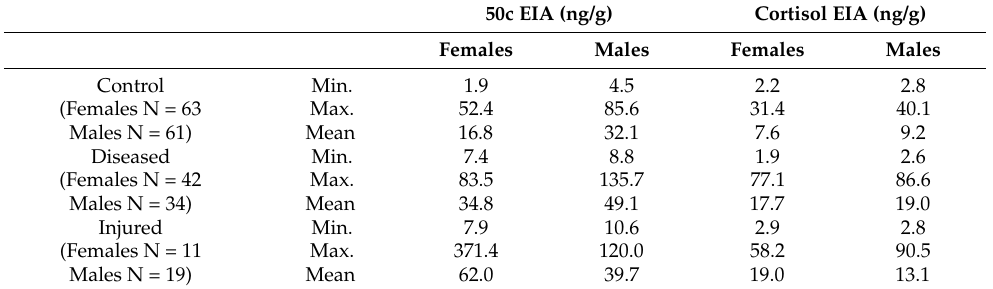
(Females N = 11 Males N = 19)